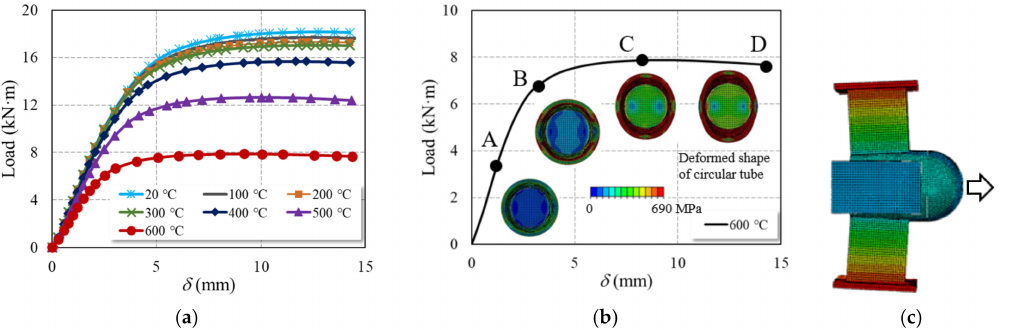
Figure 17. Effects of elevated temperatures on the load–displacement curves of specimen N1 under negative bending: ( a ) load–displacement curves; ( b ) failure process; ( c ) deformed shape correspond- ing to point C.